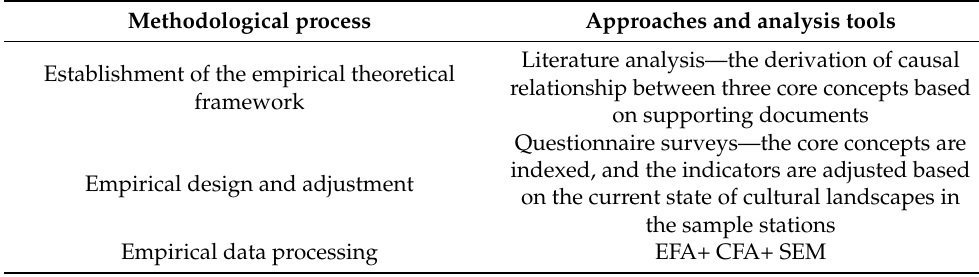
Table 1. Methodological process and approaches to empirical